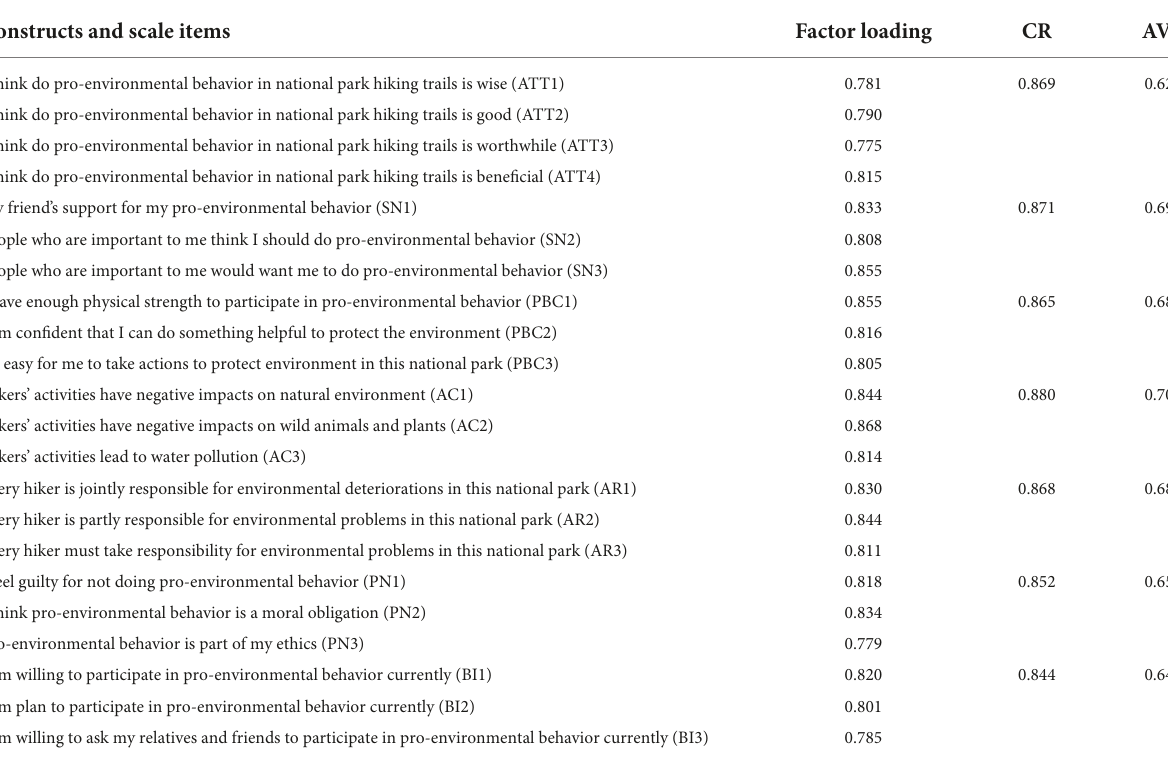
TABLE 1 Results of the confirmative factor analysis